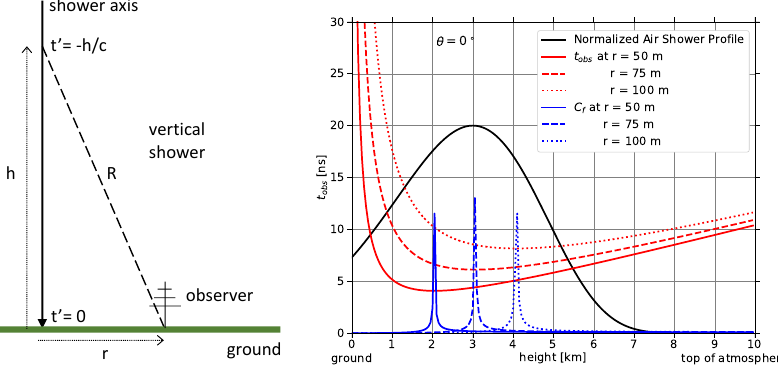
Figure 7. Left panel: Sketch of the one-dimensional toy model of radio emission in air showers. The shower development is represented by a line, neglecting the lateral spread of the shower. The shower front is assumed to travel at a speed c and reach the ground at a height h = 0 at a time t (cid:48) = 0. Radio emission from a height h travels a distance R before arriving at the observer located at a distance r to the shower axis. Right panel: Red lines: Observer time t (denoted t obs in the plot) as a function of h for observers at different r . The relation between t o bs and h is valid for vertical showers and is shown for illustration for the case of a constant refractive index n = 1.0003. Blue lines represent the factor C f as given by Equation (27) in arbitrary units. Also shown is the normalized longitudinal profile of the number of electrons and positrons in a proton-induced air shower in arbitrary units to give an idea of the relative number of particles at different